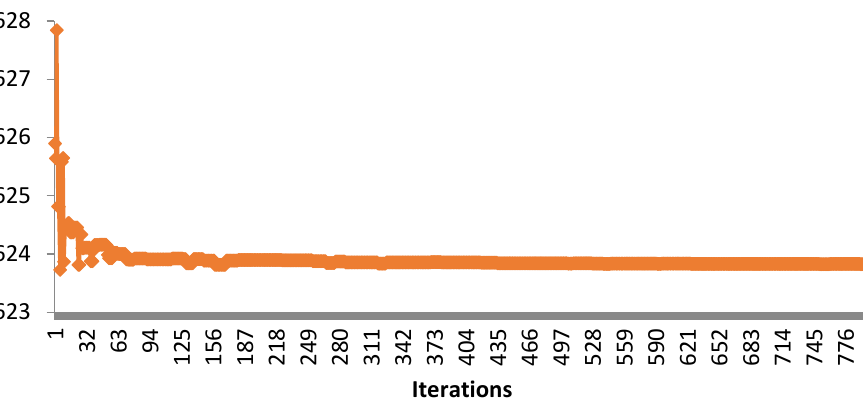
Figure 8. The convergence characteristics of the proposed for system 2 (with valve point loading effects), P d = 2700 MW.